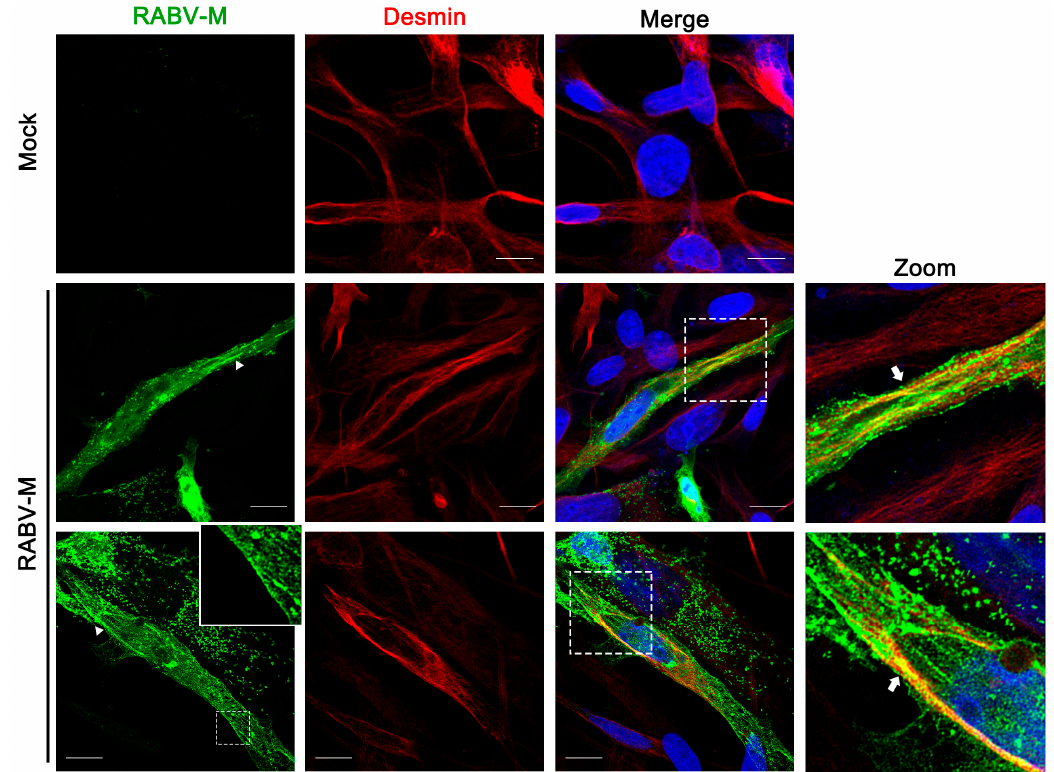
Figure 4. RABV-M co-localizes with desmin in intermediate filament bundles. The RABV-M (green), endogenous desmin (red), and cell nuclei (blue) in BHK-21 cells were visualized via confocal mi- croscopy. The insert panel in the first lane shows the RABV-M localizes to the cell periphery (plasma membrane), while the triangles indicate the bundle-like M protein. The zoom panels highlight the colocalization of RABV-M with desmin in IF bundles (indicate as arrows). Scale bars = 10 μ m.